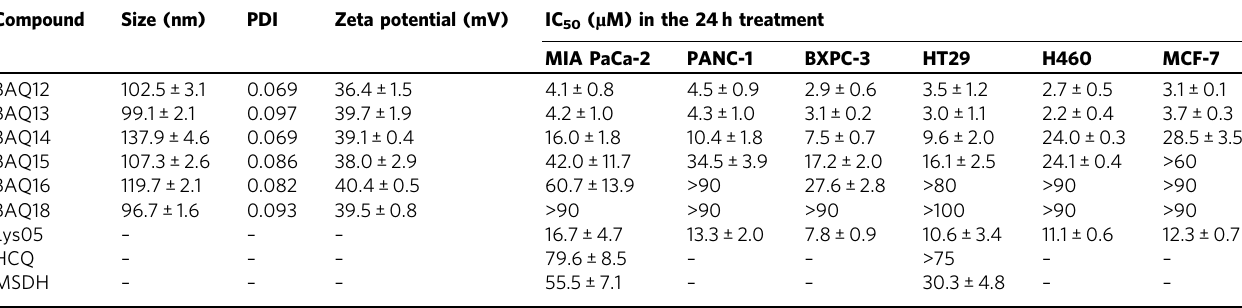
Table 1 Nanoparticle characterisation and IC 50 values on cancer cells of BAQ derivatives.